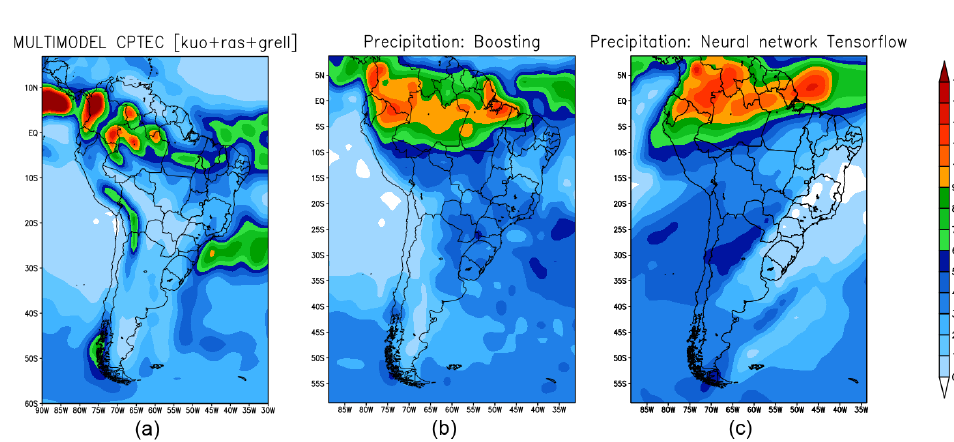
Figure 6. Seasonal climate prediction for the autumn 2019 in South America: ( a ) precipitation predicted by BAM; ( b ) precipitation predicted by XGB; ( c ) prediction obtained by TF.